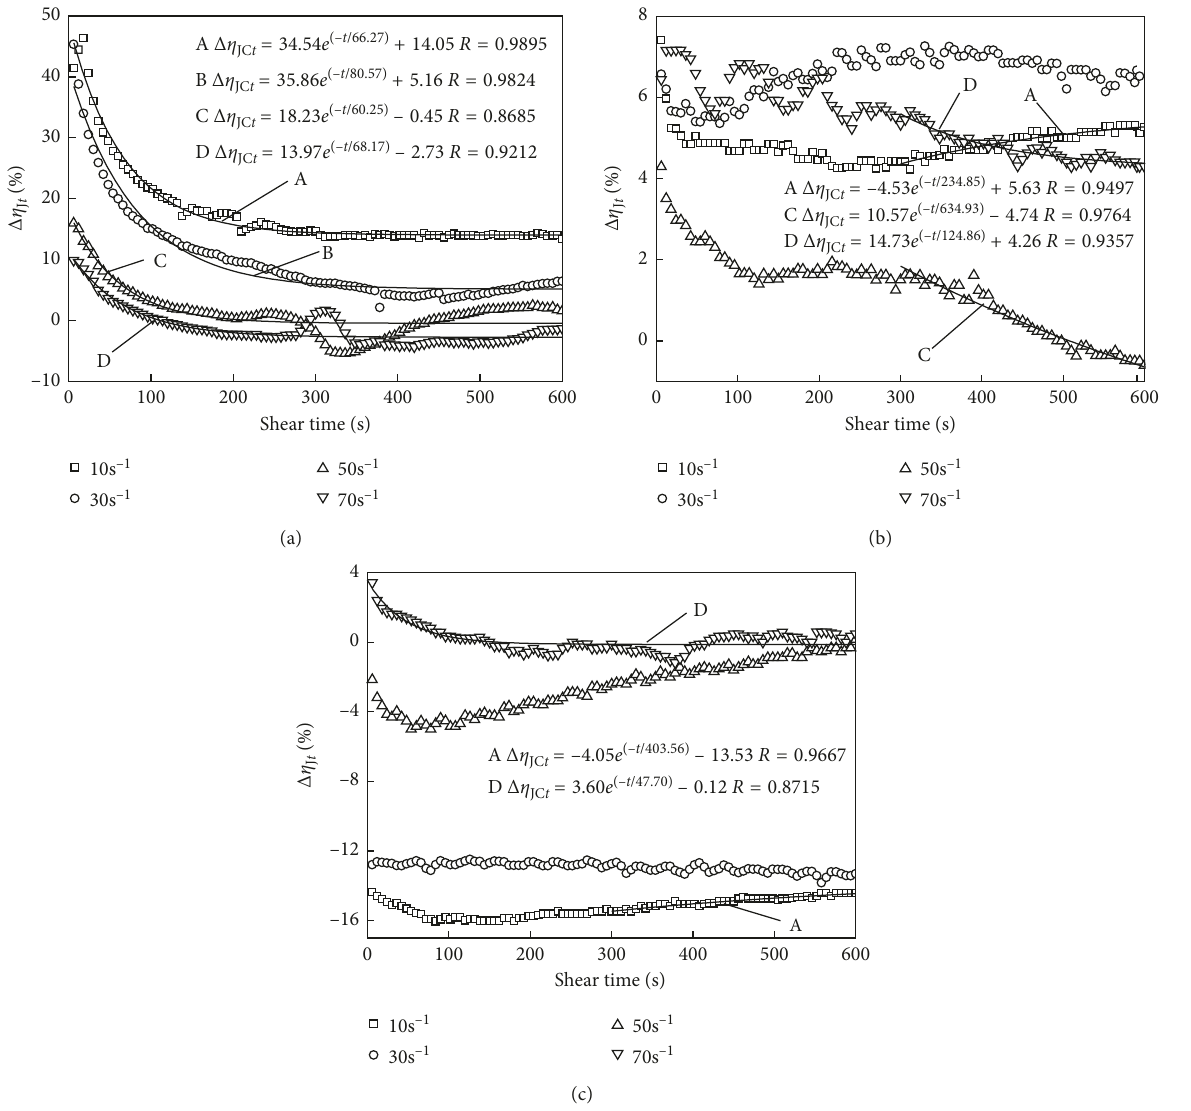
Figure 3: Varying tendency of Δ η